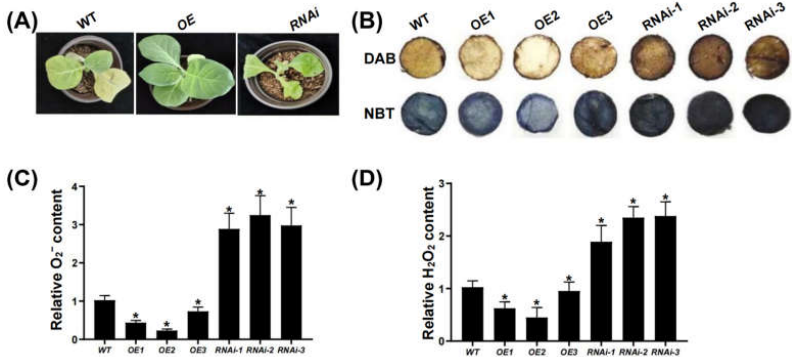
Figure 5. NtDREB-1BL1 has a role in defence against drought stress. ( A ) Phenotype of NtDREB-1BL1 OE and RNAi transgenic tobacco after drought treatment for 8 days. ( B ) DAB and NBT staining of NtDREB-1BL1 OE and RNAi transgenic tobacco after drought treatment. ( C , D ) The detailed O 2- and H 2 O 2 contents in these materials were relatively quantified by the colorimetric method. Asterisks represent statistically significant differences between WT and transgenic plants determined by Student’s t-test (*, p < 0.05).